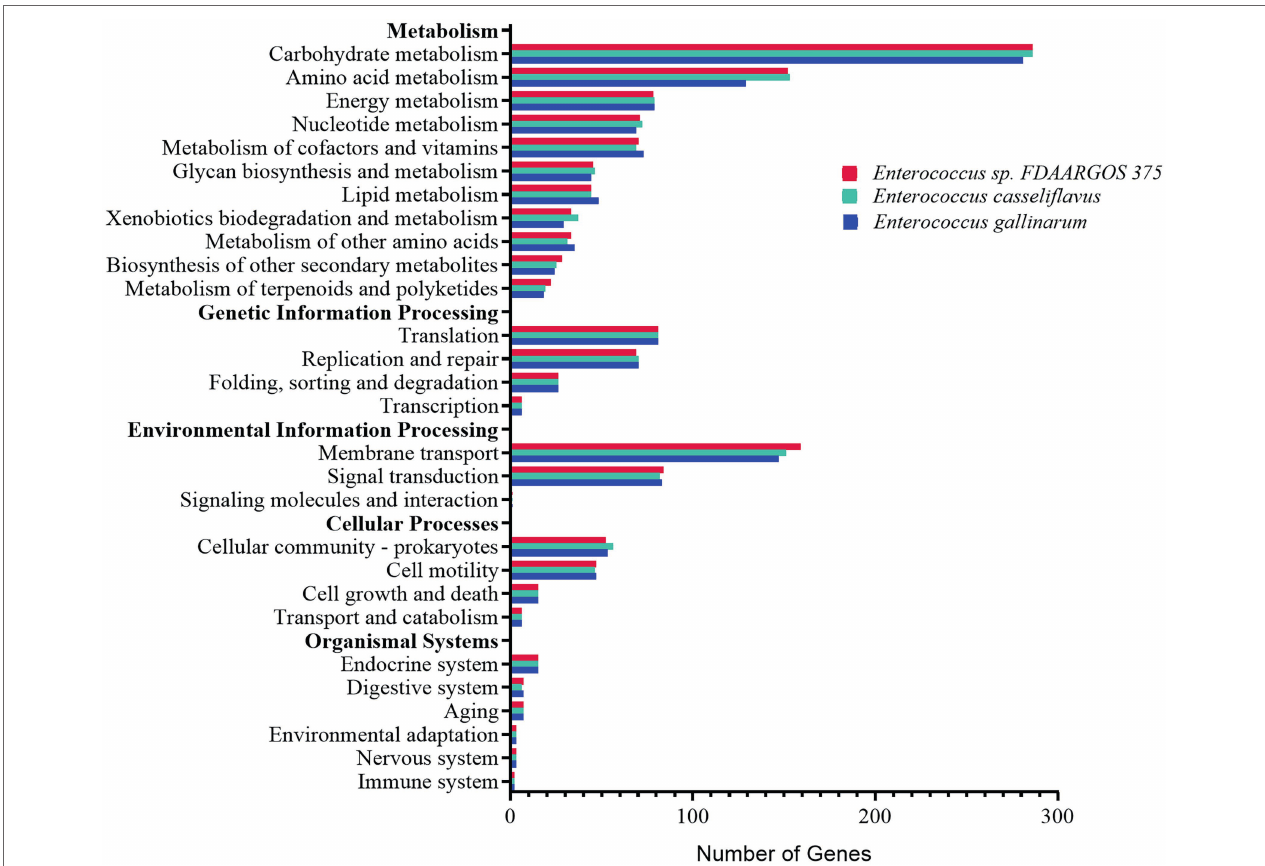
FIGURE 6 | Functional distribution analysis of genes by the KEGG main categories, from the genomes of the three most abundant Enterococcus species, Enterococcus sp. FDAARGOS-375, Enterococcus casseliflavus , and Enterococcus gallinarum